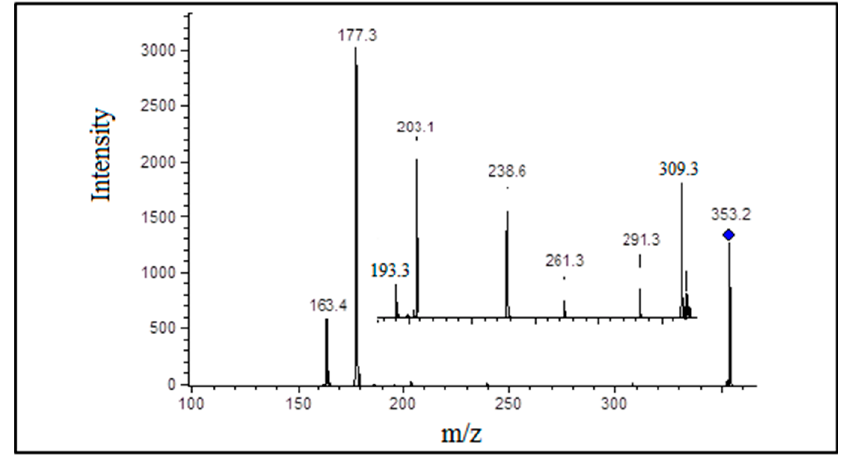
Figure 3. Structural identification of oxidized arachidonic acid by ESI-MS/MS fragmentation pattern.